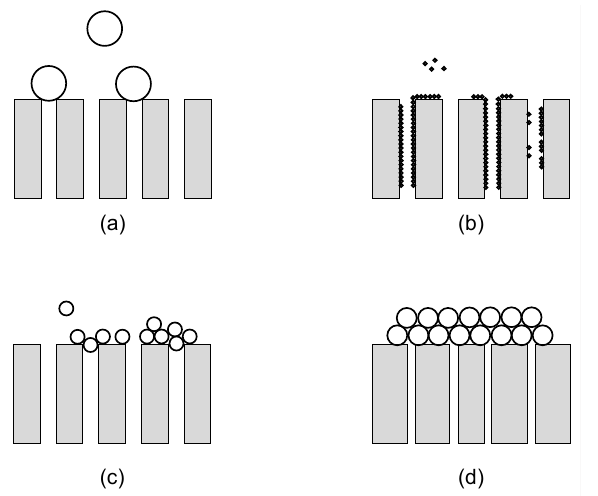
Figure 9. Hermia’s pore blocking models illustration: ( a ) Complete blocking; ( b ) standard blocking; ( c ) intermediate blocking; ( d ) cake filtration.